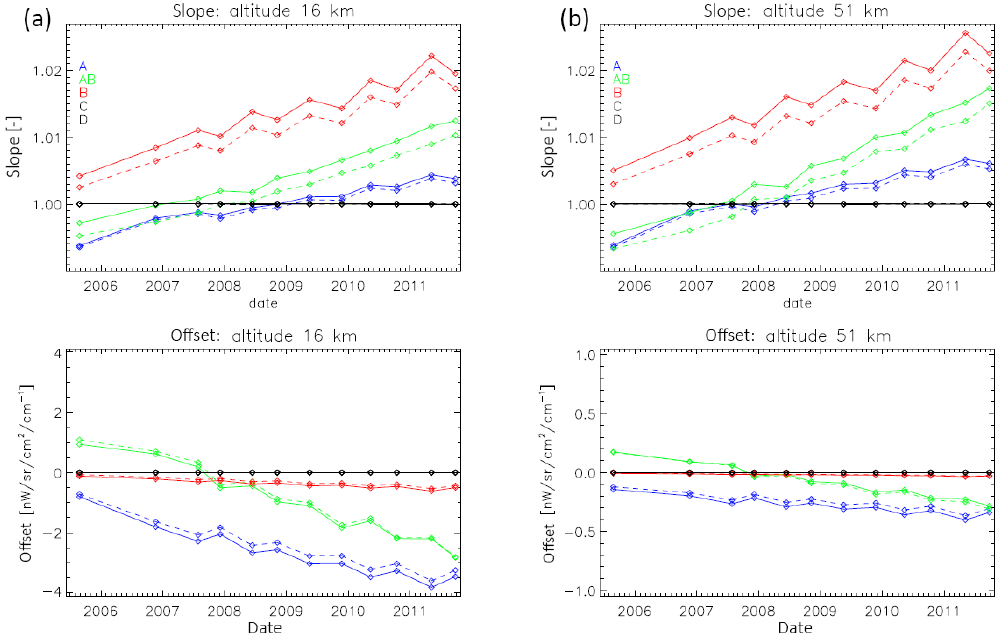
Figure 8. Slope and offset of the linear fit of MIPAS RR Level 1B spectra with the old set of NL coefficient versus spectra with the new set of NL coefficients at 16km (a) and 51km (b) . Solid lines correspond to forward mirror movement, and dashed lines correspond to reverse mirror